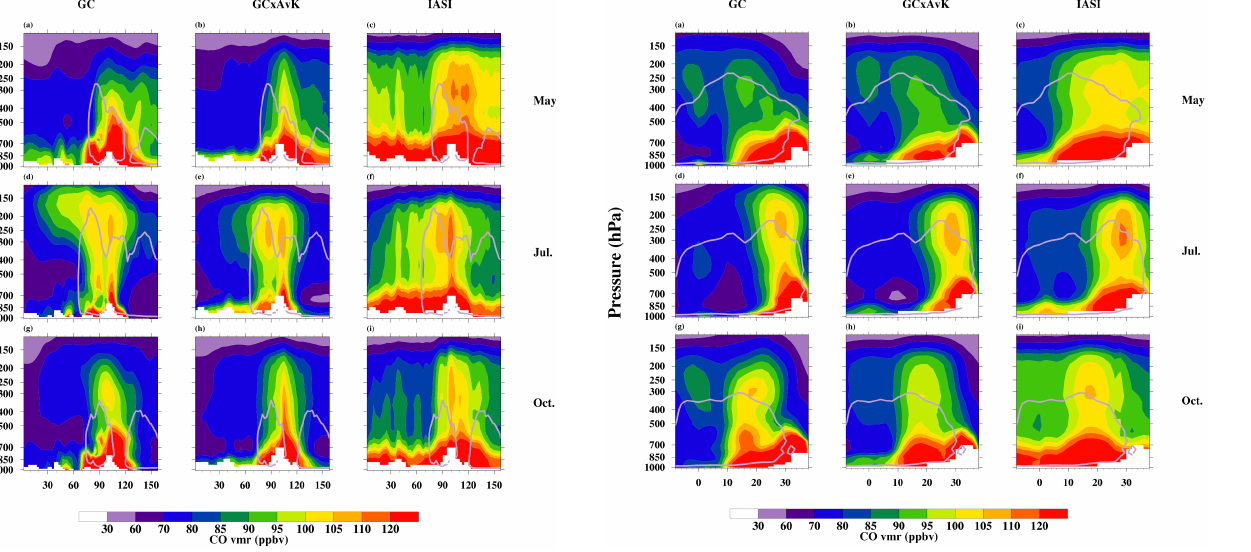
Figure 2. Longitude–pressure cross sections of CO mixing ratios averaged over 23–29 ◦ N: (a, d, g) GEOS-Chem; (b, e, h) GEOS- Chem smoothed with IASI averaging kernels; (c, f, i) IASI. From top to bottom, panels correspond to monthly periods of (a, b, c) May, (d, e, f) July and (g, h, i) October. The grey solid line represents the 2.5kgm − 2 s − 1 convective upward mass flux from GEOS-5.